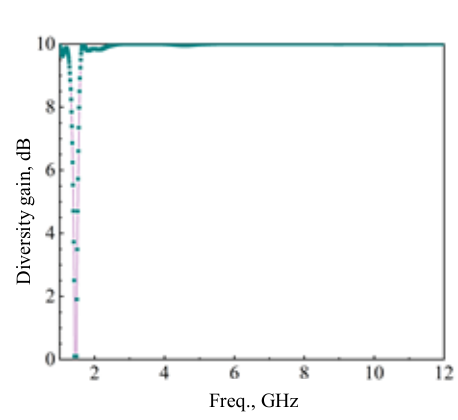
Fig. 11. TARC of the MIMO antenna system when ϴ changed from 0° to 180°.